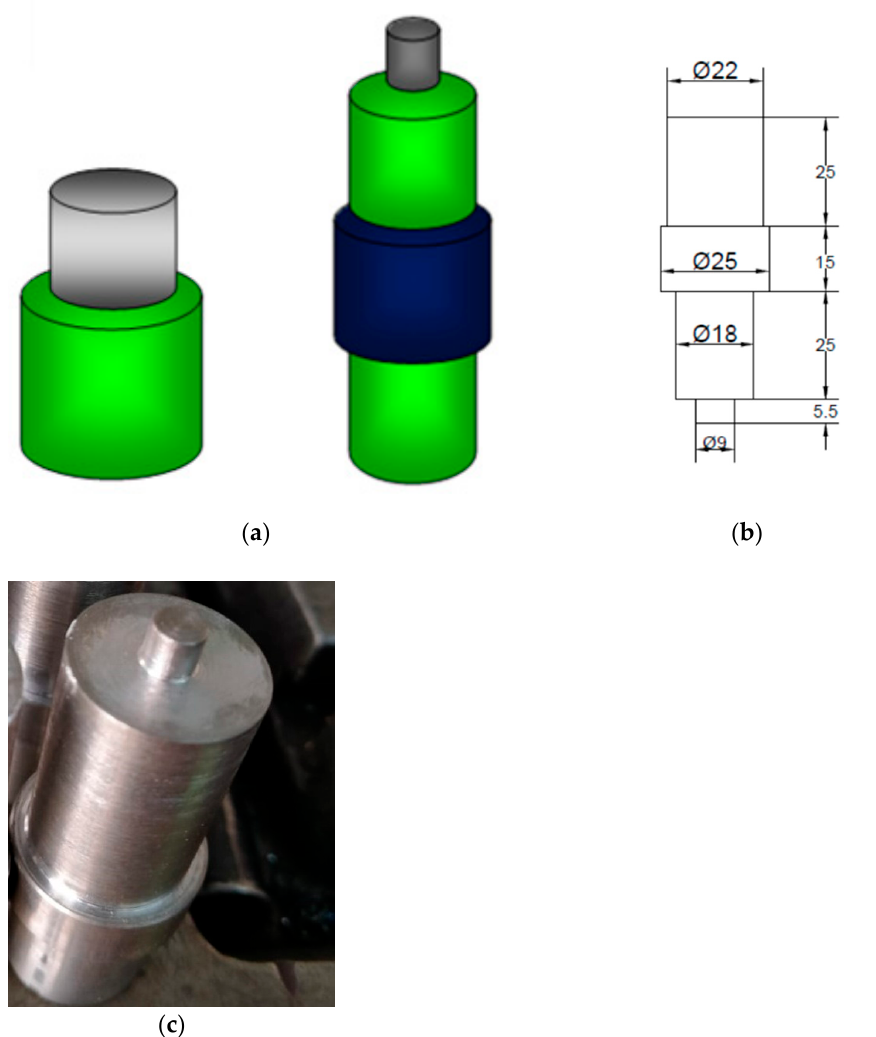
Figure 1. FSP tool: ( a ) compacting and FSP tool shape feature; ( b ) dimensional feature of FSP tool; ( c ) fabricated FSP tool.